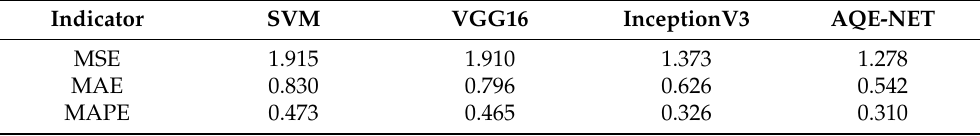
Table 4. MSE, MAE, and MAPE metrics for SVM, VGG16, InceptionV3, and AQE-Net models.